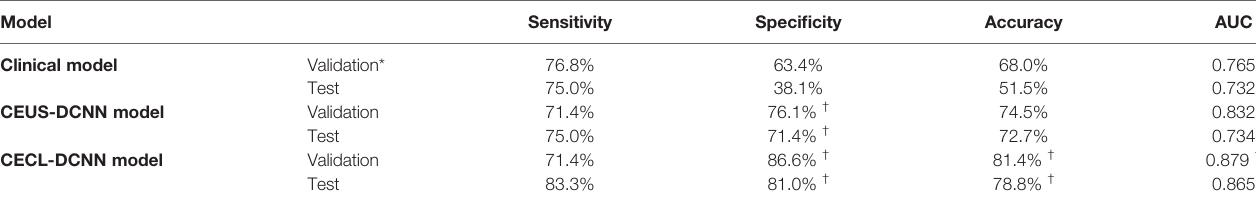
AUC, area under the curve. *Multivariate logistic analysis was used. † The comparison with the clinical model was signi fi cant, p < 0.05.